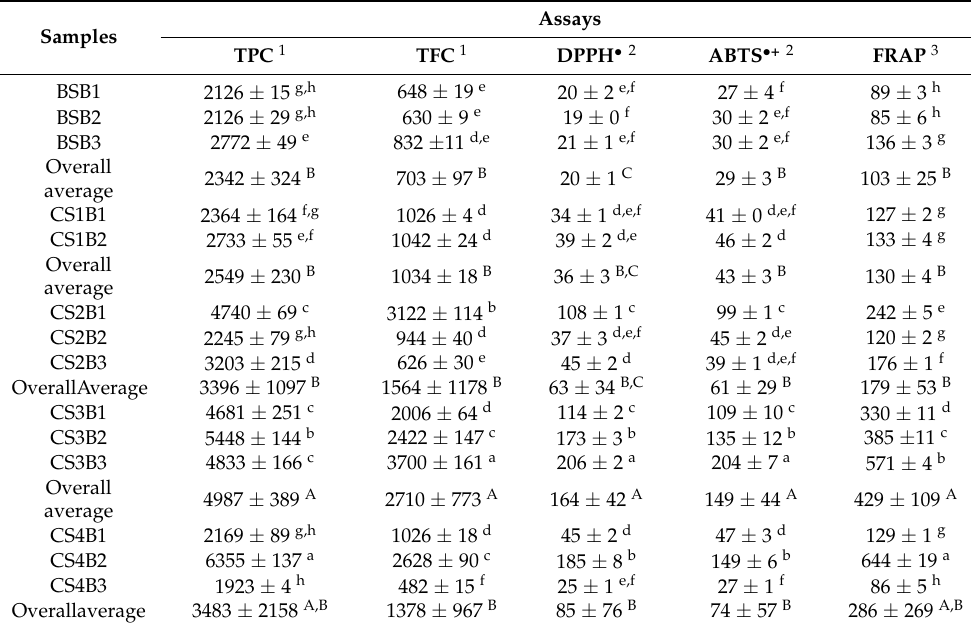
Abbreviations in the “Samples” column represent the different batches of each one of the brands evaluated. Different lowercase letters in the same column indicate that the results are statistically different ( p < 0.05). Different uppercase letters in the same column indicate a statistically significant difference among groups (BS, CS1, CS2, CS3 and CS4) ( p < 0.05). 1 Results expressed as mg RE/ 100 g. 2 Results expressed as µ mol Trolox/g. 3 Results expressed as µ mol Fe 2+ /g. BSB1 = botanical sample batch 1; BSB2 = botanical sample batch 2; BSB3 = botanical sample batch 3; CS1B1 = commercial sample 1 batch 1; CS1B2=commercial sample 1 batch 2; CS2B1 = commercial sample